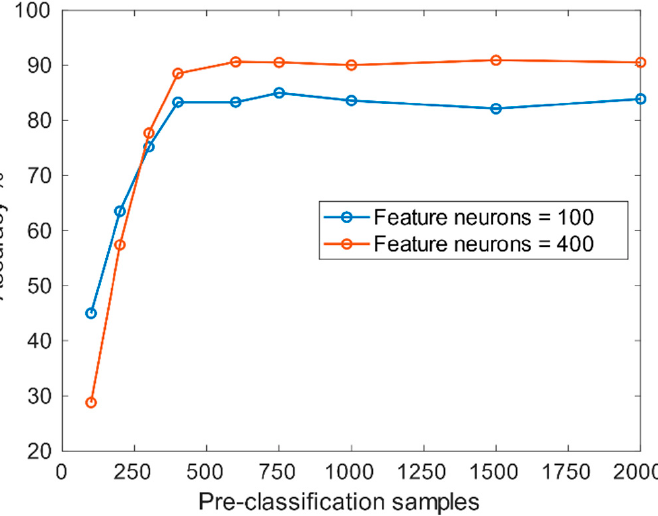
Figure 9. Impact of the number of pre-classified samples on accuracy when the number of feature neurons is 100 or 400.